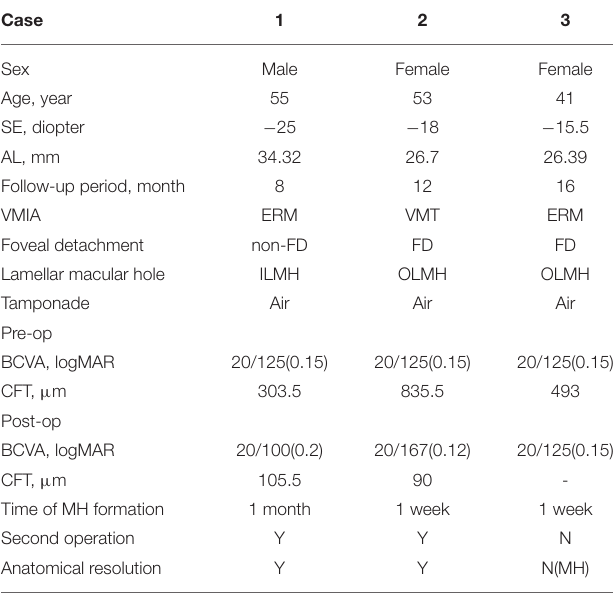
TABLE 4 | Data of eyes developed postoperative macular